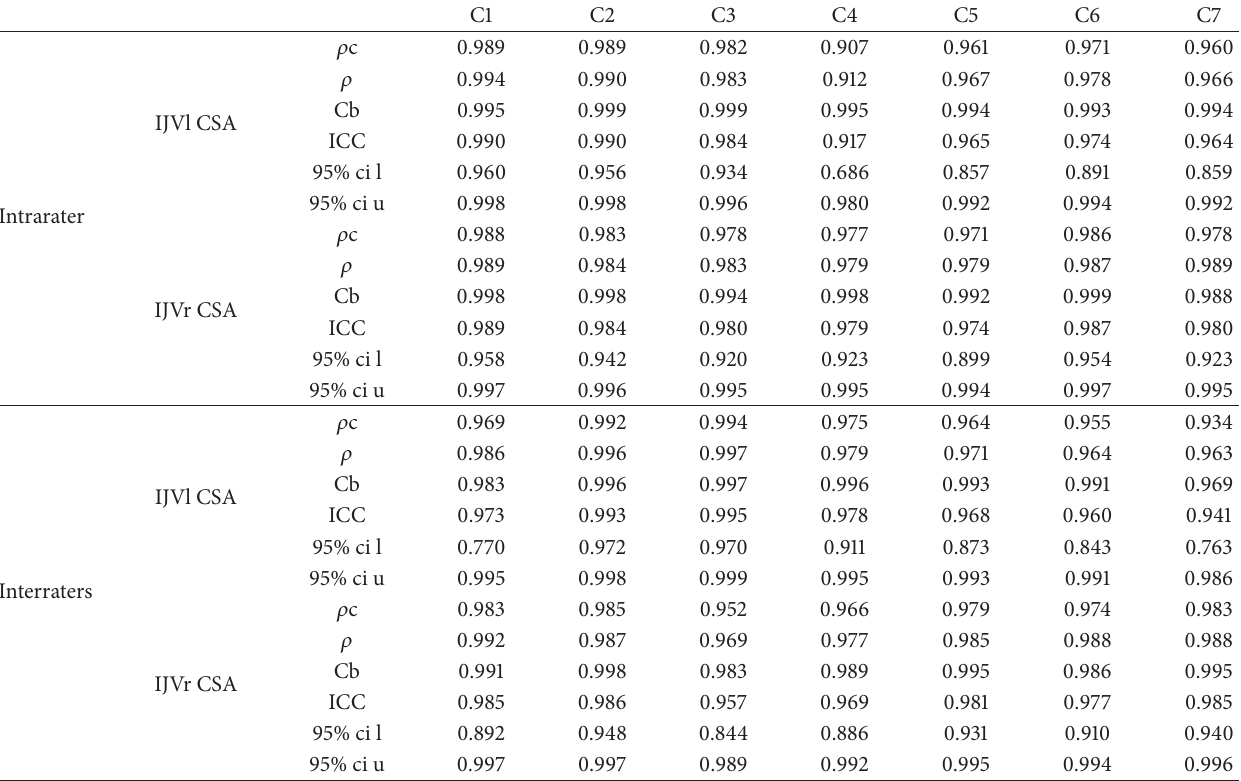
Table 2: Intrarater and interraters variability of IJVl and IJVr CSA for all cervical levels from C1 to C7. The concordance correlation coefficient ( 𝜌 c), expressed also as precision ( 𝜌 ) and accuracy (Cb), is reported. The intraclass correlation coefficient (ICC) is represented with its 95% lower (ci l) and upper (ci u) confidence interval bounds. Data shows almost perfect agreement ( 𝜌 c > 0.90) and no systematic differences (ICC > 0.9) between raters at each cervical level.